Question: What visual encoding does this figure use to show its data?
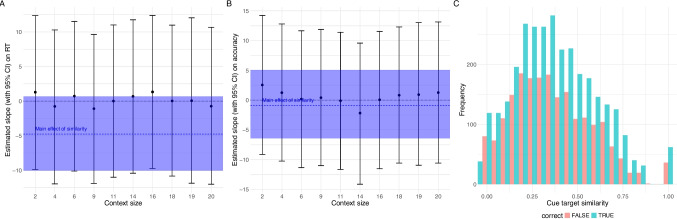
Answer: histogram